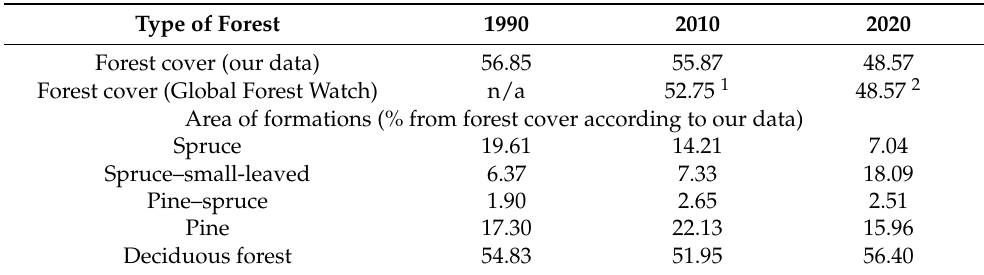
Table 4. Composition of coniferous formations in the periods 1990, 2010, and 2020,